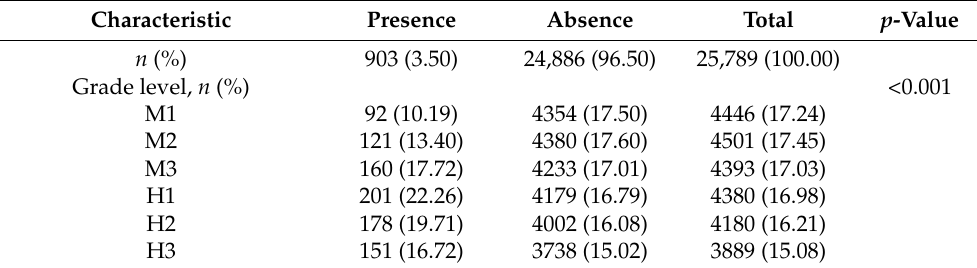
Table 1. Participants’ characteristics according to the presence of self-perceived PLMS. Characteristic Presence